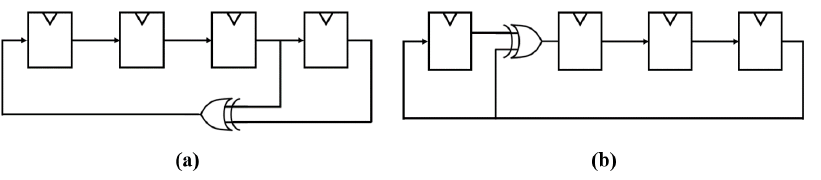
Figure 3. Circuit of Fibonacci LFSR and Galois LFSR to obtain random numbers ( a ) Fibonacci LFSR ( b ) Galois LFSR.